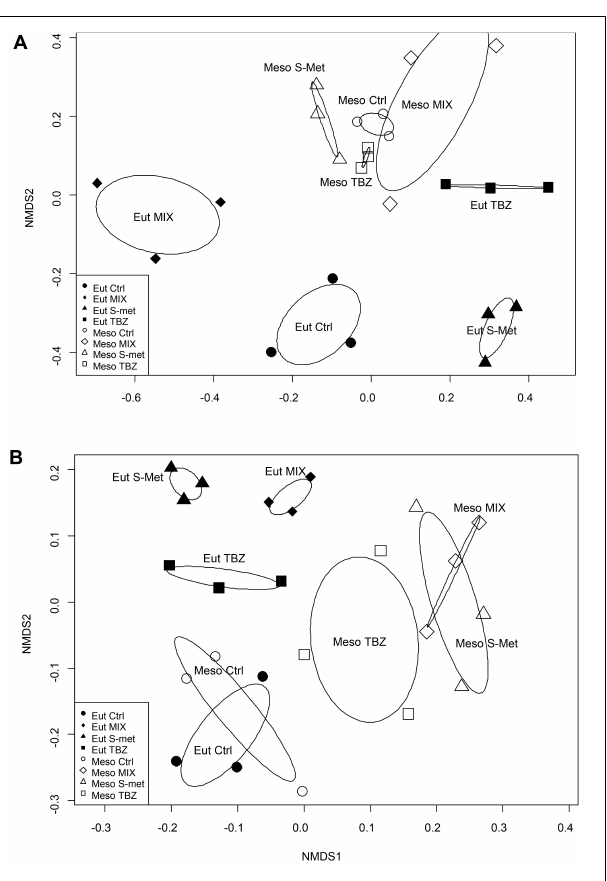
differences between nutrient conditions and pesticide treatments were mostly explained by OTUs replacement. However, control for both mesotrophic and eutrophic condition displayer lower OTUs richness compared to pesticides exposed treatments (both TBZ, S-Met and